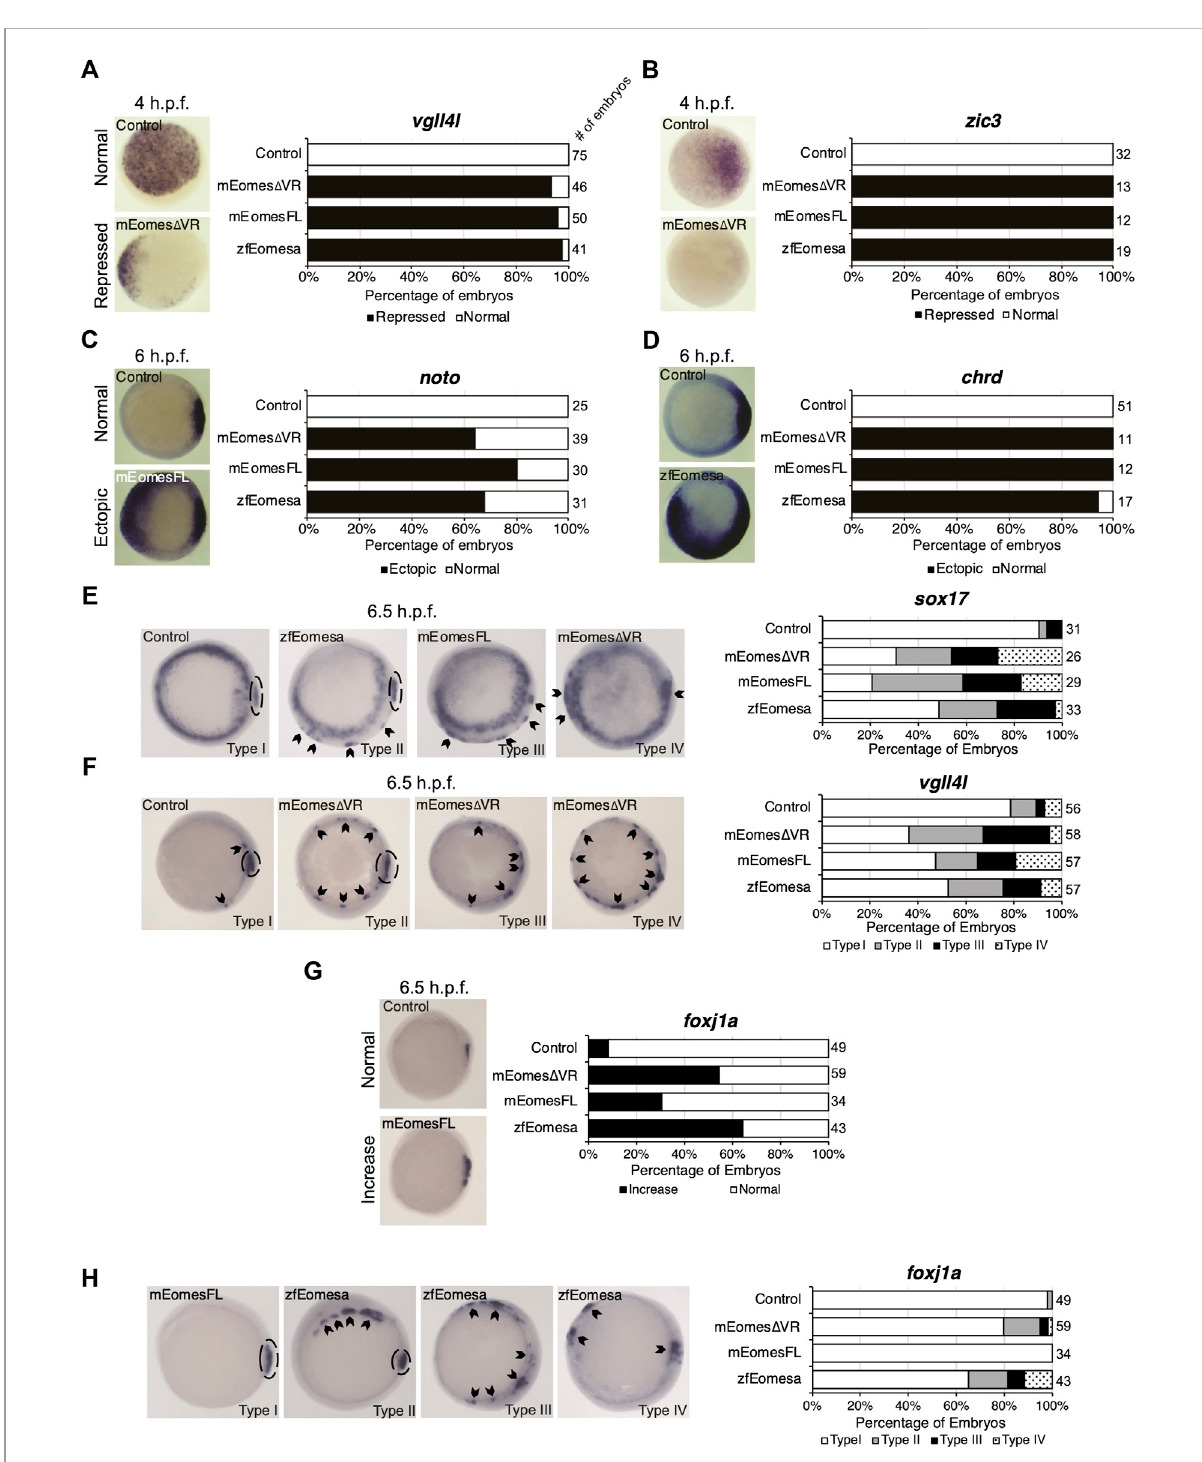
FIGURE 2 Both FL and Δ VR isoforms of mouse Eomes are functionally equivalent to zebra fi sh Eomesa in the early embryo. WISH analysis of ectoderm markers vgll4l and zic3 inmid/lateblastulas(4 h.p.f.)embryos (A,B) ,organisermarkers noto and chrd (C,D) inearlygastrulas(6 h.p.f.),orDFCmarkers sox17 , vgll4l and foxj1a (E – H) inearly/midgastrulas (6.5 h.p.f.).Embryos have beeninjected atthe1 cell stageto overexpresseithermouse EomesFL, Eomes Δ VR or zebra fi sh Eomesa. N = 2. Total numbers of embryos scored per condition are indicated. Representative images of expression patternspergenepercategoryareshown. (A – D) Animalviews;dorsaltotheright. (E) Animalviews;dorsaltotheright. (F – H) Vegetalviews;dorsalto the right. Panel G indicates the percentage of embryos with greater intensity of dorsal foxj1a WISH staining, while panel H indicates percentages